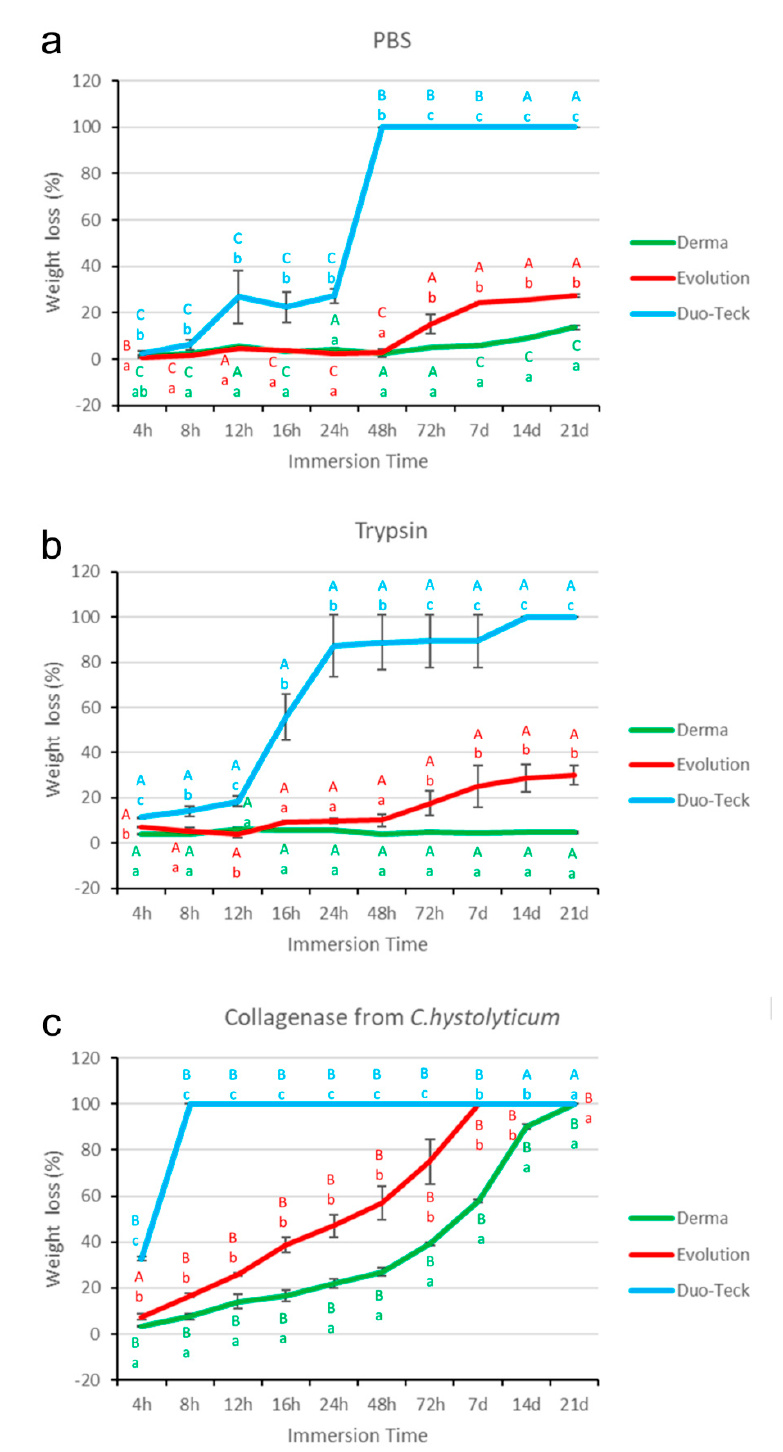
Figure 2. Degradation profile by % weight loss analysis of the three experimental membranes (Derma Fina, Evolution Standard and Duo-Teck) over immersion periods up to 21 days in: ( a ) PBS, ( b ) trypsin and ( c ) collagenase from Clostridium histolyticum . Values shown are mean and standard deviation (n = 3). Significant di ff erences between membranes within the same immersion solution are noted by low-case letters. Di ff erences between di ff erent immersion solutions within the same membrane are pointed out with capital letters. Multiple comparisons were performed by Student-Newman-Keuls p < 0.05).